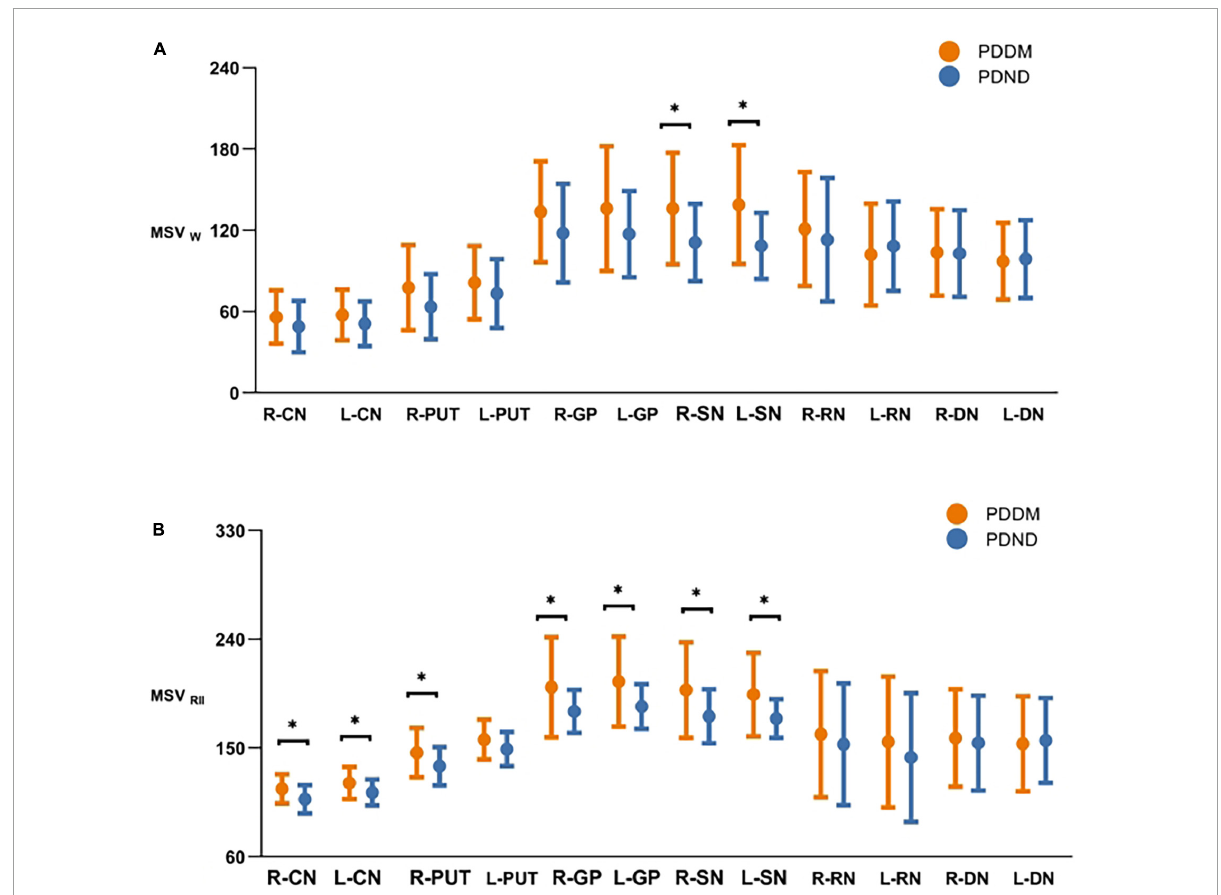
FIGURE2 Comparisons of MSVw and MSV RII of gray matter nucleus in brain between PDDM and PDND group. The results in the figures showed that iron deposition in the PDDM group was greater than that in the PDND group in most nuclei except for the R-DN. For MSVw, there were significant differences in the R-SN and L-SN (A) ; For MSV RII , there were significant differences in the R-CN, L-CN, R-PUT, R-GP, L-GP, R-SN, and L-SN (B) . ∗ P < 0.05. MSV W , MSV of the whole nuclei; MSV RII , MSV of the high iron region; PDDM, PD with T2DM; PDND, PD without 20 T2DM; R, right; L, left; CN, caudate nucleus; PUT, putamen; GP, globus pallidus; SN, substantia nigra; RN, red nucleus; DN, dentate nucleus.